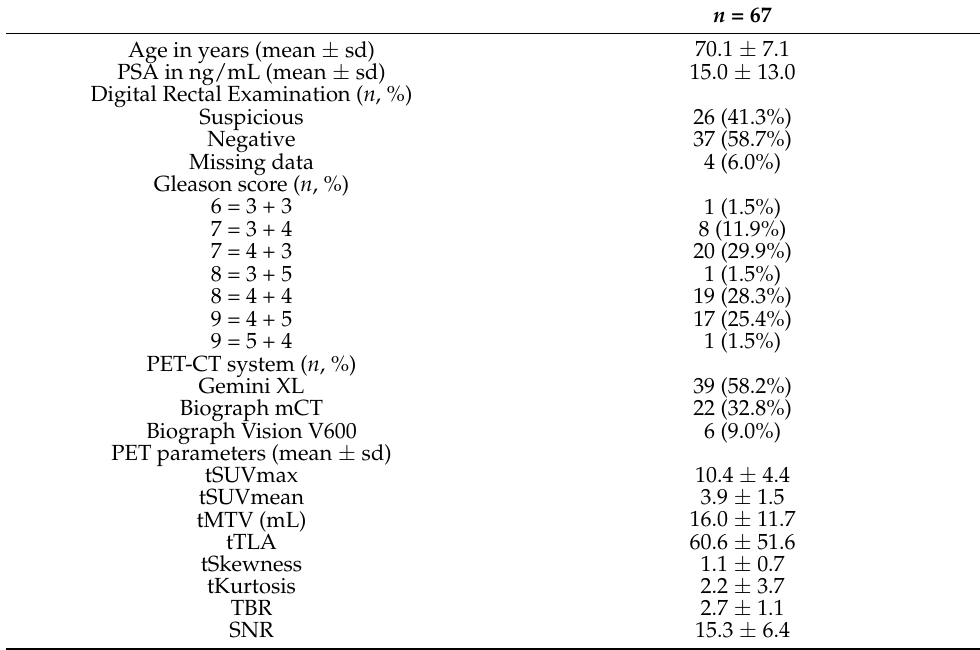
Table 1. Descriptive analysis of patients’